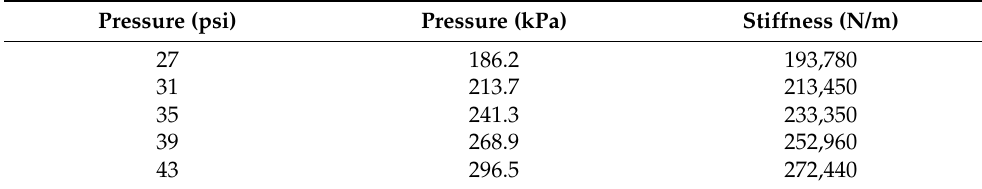
Table 1. Measurement of tire vertical stiffness with different